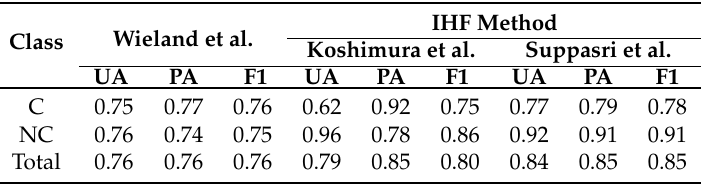
Table 6. Performance comparison between the IHF method and that of Wieland et al. [16]. IHF, imagery, hazard and